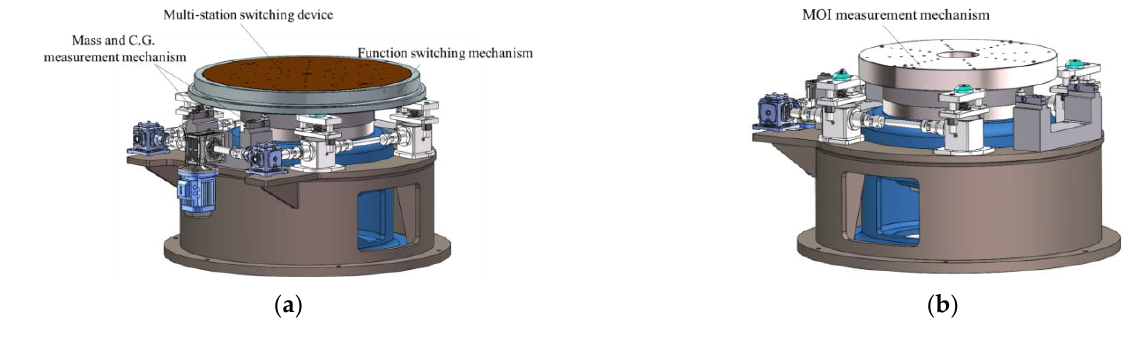
Figure 6. (a) The effect picture of mass property measuring table.; ( b ) The effect picture of mass Figure 6. ( a ) The effect picture of mass property measuring table; ( b ) The effect picture of mass property measuring table without the multi-station switching device. property measuring table without the multi-station switching device.